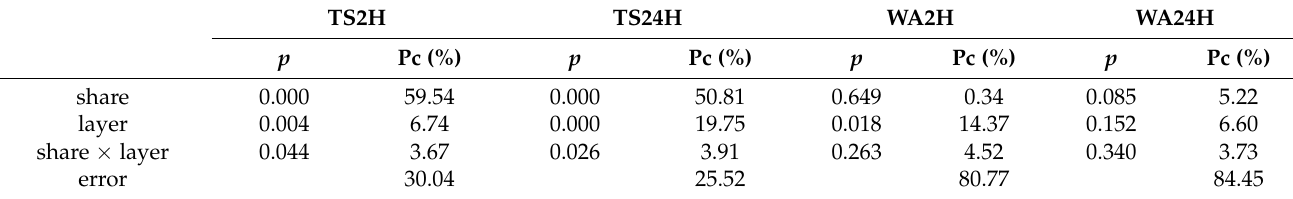
Table 5. Statistical significance of factor influence on physical properties of